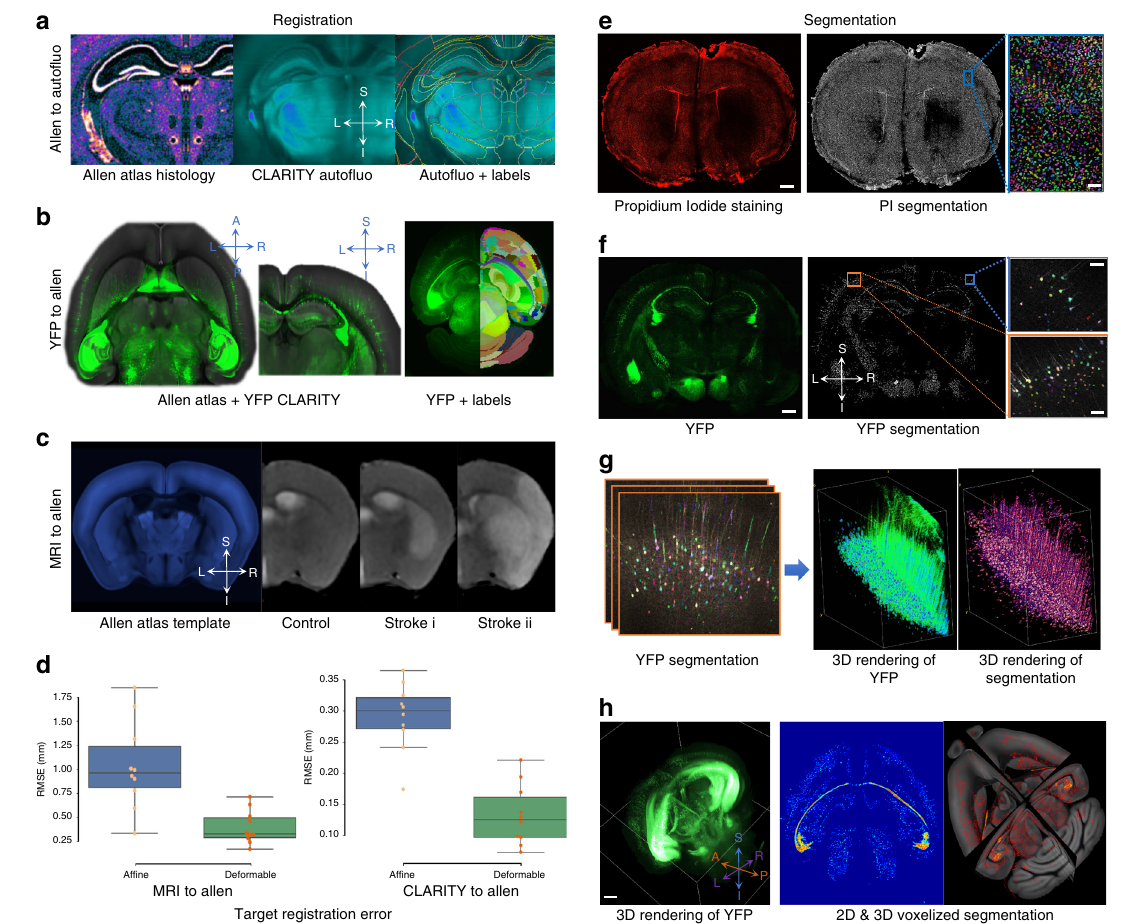
Fig. 2 Validation highlighting MIRACL ’ s registration and segmentation accuracy. a High fi delity of CLARITY registration to the Allen Regional Atlas (ARA). Left: Coronal view of an ARA Nissl histology slice. Center: CLARITY auto- fl uorescence channel of a representative stroke mouse registered to the ARA. Right: The same auto- fl uorescence channel with overlaid label outlines (R – L: right – left, S-I: superior – inferior). b Axial and coronal views of a Thy1 yellow fl uorescence protein (YFP) imaging volume (green) registered to the ARA template (grayscale) and an axial view of another registered CLARITY dataset with (right) and without (left) ARA labels. c Coronal views of three Allen-registered in vivo MR images (a control mouse, a striatal stroke mouse, and a cortico-striatal stroke, respectively). All mice in this study were scanned 24 h after stroke. d Low root mean squared error (RMSE) between transformed manually placed landmarks on the native MRI and CLARITY imaging volumes and ARA manually placed landmarks. Center line of box plot represents the median, bounds represent the fi rst and third quantiles, and whiskers represent the lowest and highest datum within 1.5× the interquartile range of the lower and upper quantiles. e Segmentation results for nuclei using propidium iodide (PI) stain. Coronal view of a PI stroke brain and its corresponding segmentation image (scale bar: 400 µ m). Inset (right) shows a zoom-in view on cortex ipsilateral to the stroke with individually segmented cells shown in random colors overlaid on the original PI image (scale bar: 100 µ m). f Segmentation results for layer-speci fi c neurons using Thy1-YFP (YFP). Coronal view of a Thy1-YFP stroke brain and its segmentation image (scale bar: 400 µ m). Insets (right) show zoom-in views on the cortex contralateral to the stroke (orange box) and cortex ipsilateral to the stroke (blue box) (scale bars: 50 µ m). g Zoom-in on YFP results with segmentation overlaid on raw images, and 3D rendering of YFP raw and segmented neurons. h 3D rendering of an original YFP volume with a 5- µ m isotropic resolution (left) and examples of voxelized segmentation results (where the segmentation images are summarized at lower resolutions in the Allen space) at 25 µ m in two- and three- dimensions (scale bar: 600 µ the rate of diffusion and degree of unidirectional restriction/ hindrance in water movement. These voxelwise YFP and PI heat- maps showed cell loss in the caudoputamen (CP) and overlying sensory and motor cortex, with corresponding T2 and MD heat- maps showing in vivo changes to the same regions. To further assess inter-hemispheric differences within the stroke mice, a label-wise paired t test was calculated between ipsilesional (same side as stroke) and contralesional hemispheres in each ARA region for CLARITY cell counts and MRI measures (Fig. 3b). The pipeline accounts for the relatively lower resolution of MRI by grouping ARA labels to their “ grand-parent labels ” according to the ARA ontology hierarchy (e.g., the grand-parent label of layer 1 of the primary somatosensory nose area is the primary